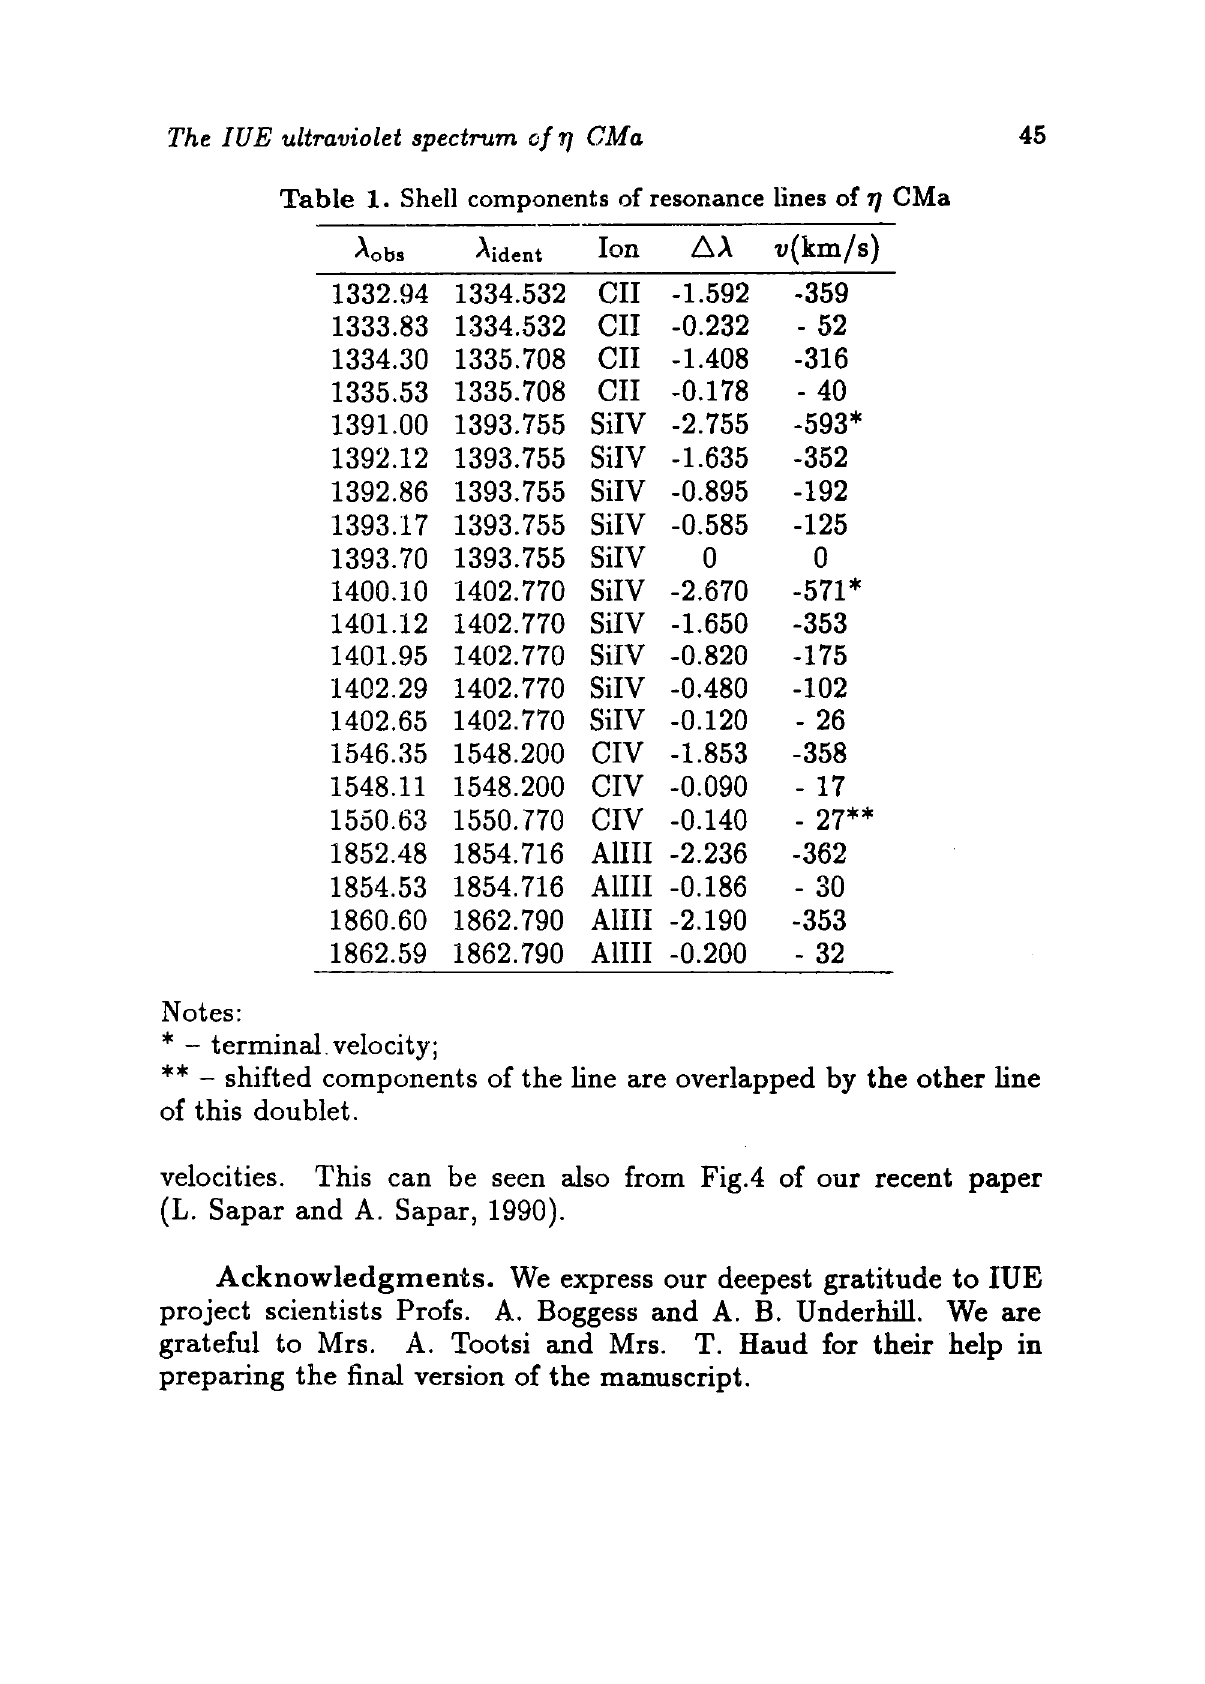
Table 1. Shell components of resonance lines of r] CMa A 0 bs Aident